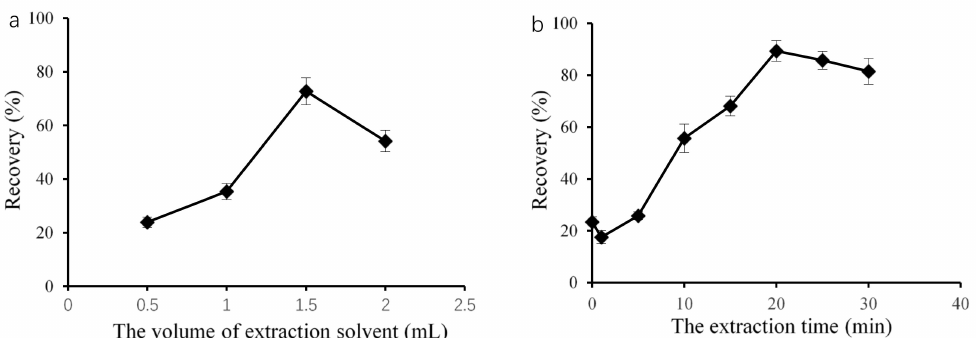
Figure 1. Effect of the petroleum ether microextraction conditions on target recovery: extraction solvent volume ( a ) and the extraction time ( b